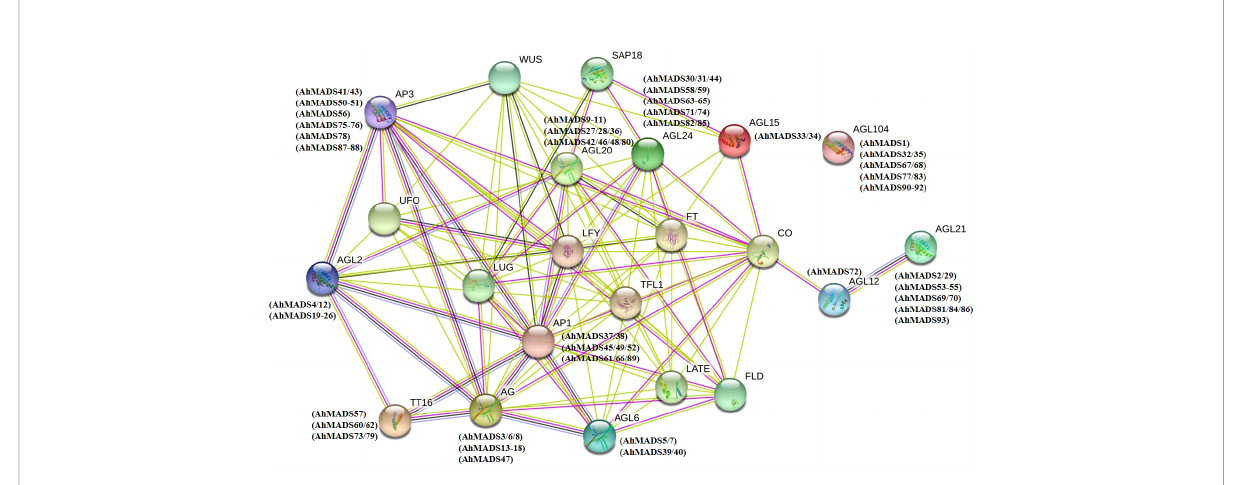
FIGURE 3 Interaction networks of AhMADS in peanut based on Arabidopsis data.